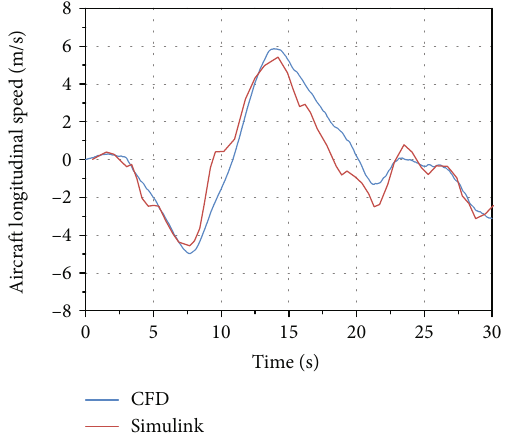
Figure 8: Aircraft longitudinal speed comparison rail is fi xed in the adapters [19]. The main structure is shown in Figures 9 and